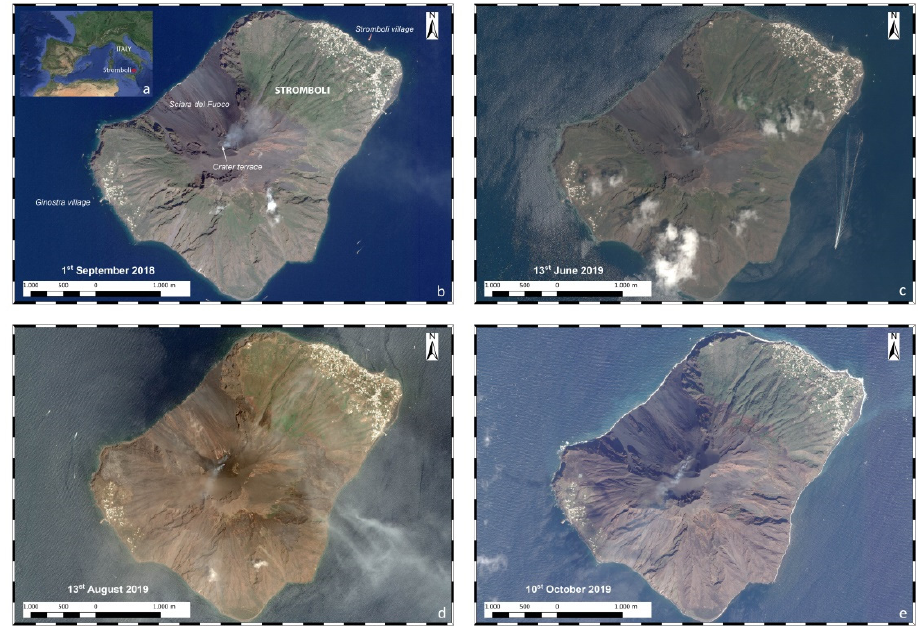
Figure 1. ( a ) Geographic location of the Island of Stromboli (Google Earth image); PLÉIADES ‐ 1 images collected on ( b ) 1 st September 2018; ( c ) 13 th June 2019; ( d ) 13 th August 2019; ( e ) 8 th October 2019.